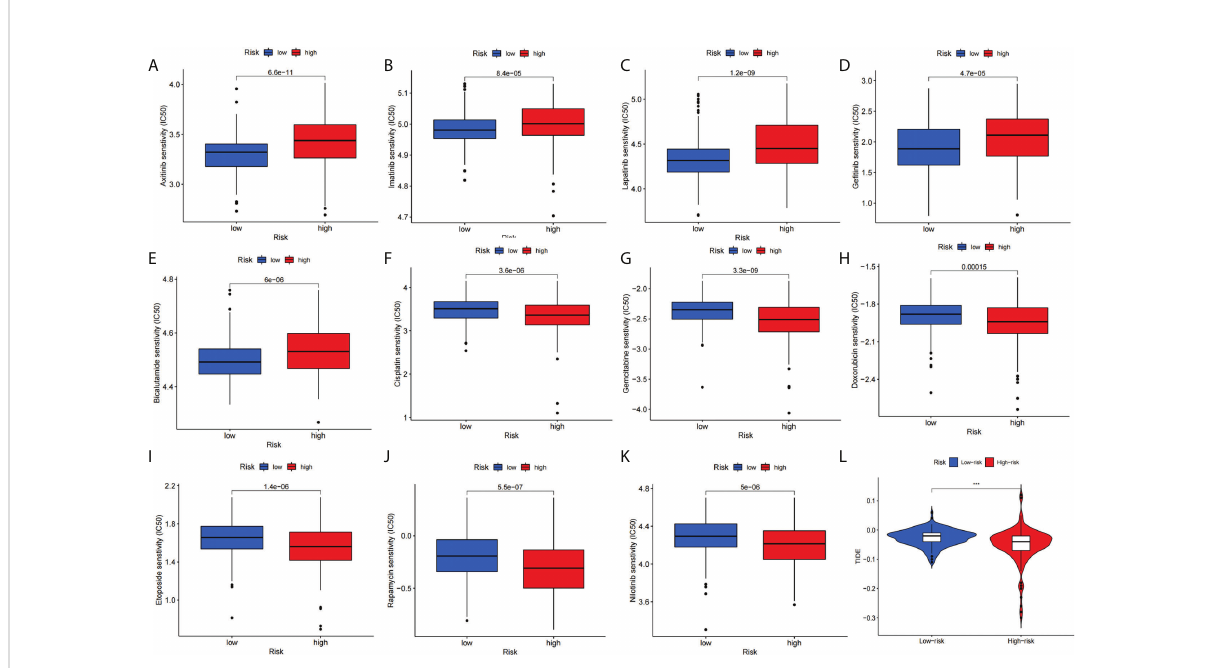
FIGURE 10 Signature predicts chemotherapy and immunotherapy response. (A – E) The signature showed high-risk scores were associated with a lower IC50 for chemotherapeutics such as (A) Axitinib, (B) Imatinib, (C) Lapatinib, (D) Ge fi tinib, and (E) Bicalutamide, whereas they were related to a higher IC50 for (F) Cisplatin, (G) Gemcitabine, (H) Doxorubicin, (I) Etoposide, (J) Rapamycin and (K) Nilotinib treatment. (L) Differences in TIDE score between high- and low-risk